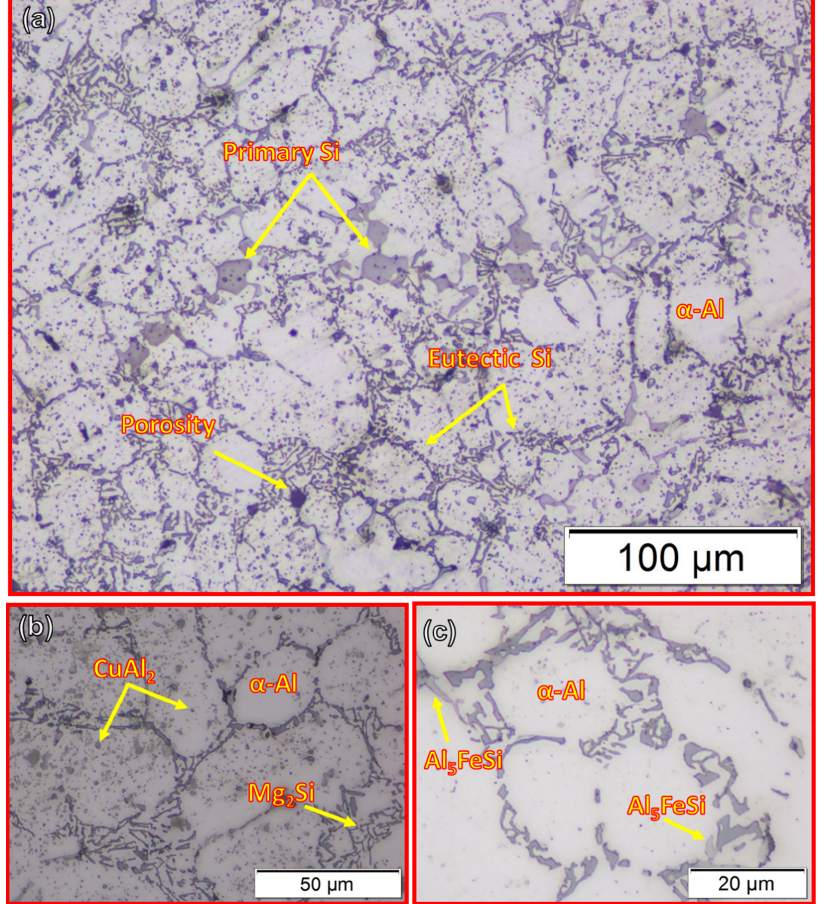
Figure 8 . OM micrographs show the microstructure of ( a ) the as-cast A356 alloy, ( b , c ) at higher magnifications.